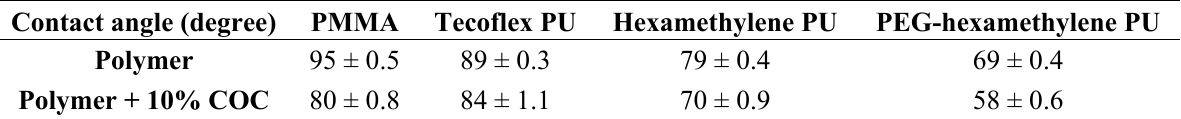
Table 1. The contact angle on polymer and polymer-COC